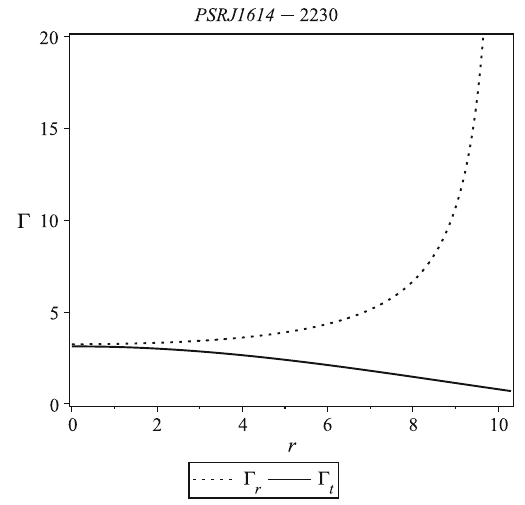
Fig. 8 Variation of the EOS parameter ω ef f r and ω ef f